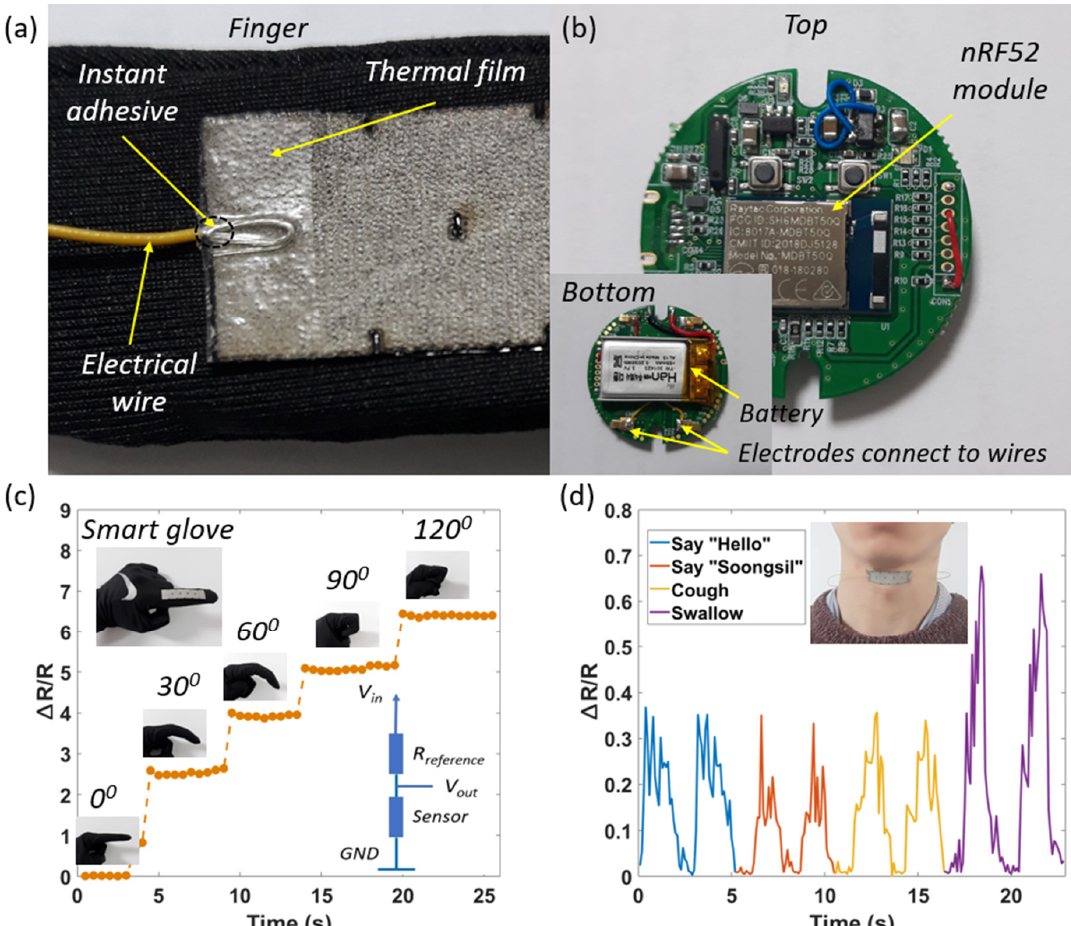
Figure 9. ( a ) structure of sensors on fingers, ( b ) hardware platform, ( c ) signals of finger motions at different angles, and ( d ) signals of pharynx motions when speaking, coughing, and swallowing.